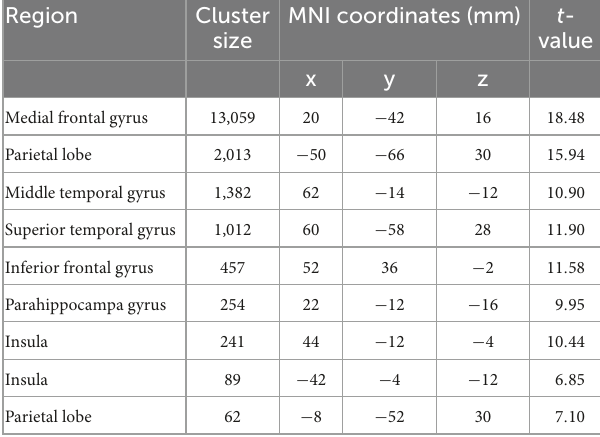
TABLE 2 Brain regions showing significant larger activation in the contrast of SS >